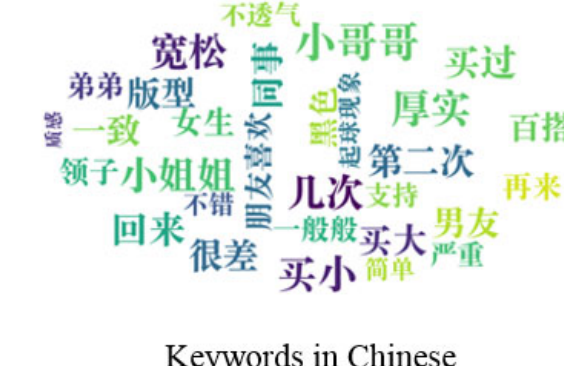
Figure 5. The most different words under different product consideration (10 products).